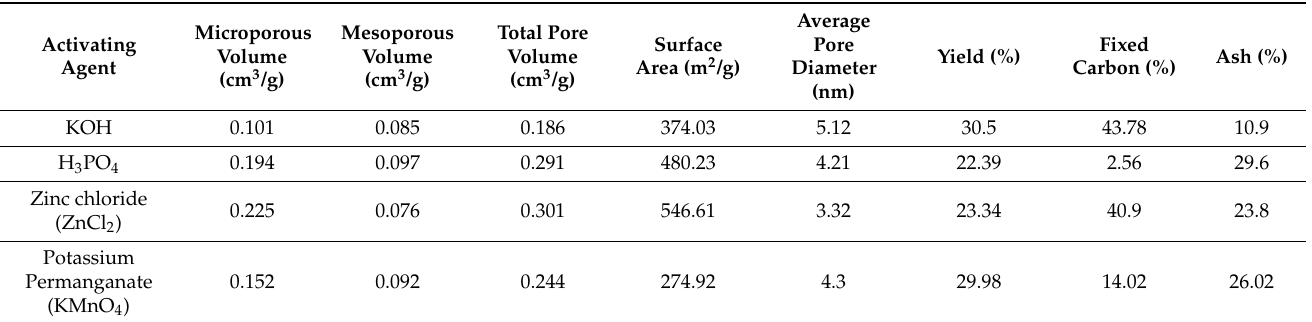
Table 3. Textural properties of sago wastes-based activated carbon produced by using different chemical activation agents